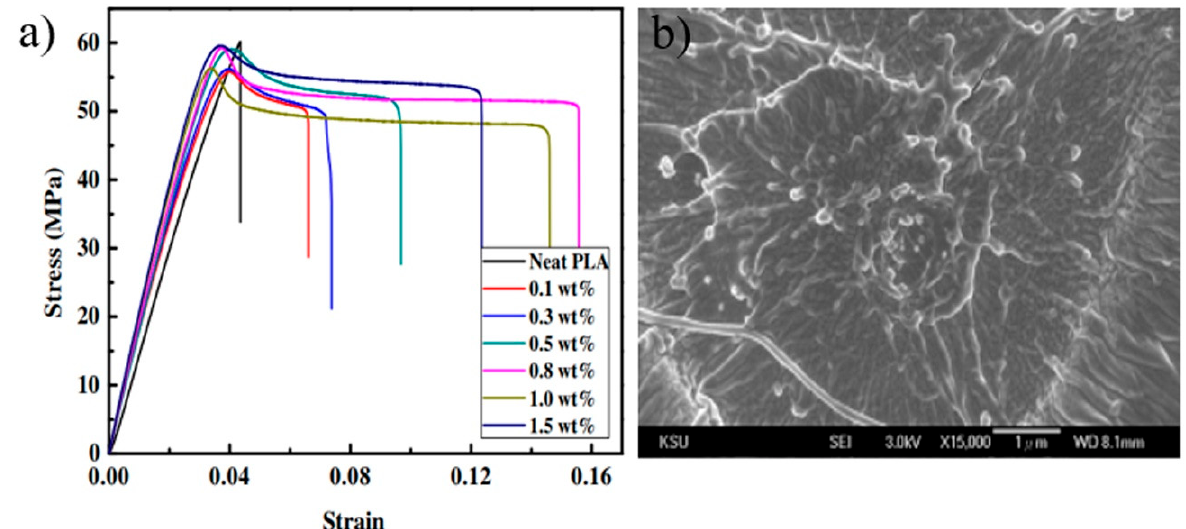
Figure 6. ( a ) The stress–strain curve of neat PLA and PLA composites. ( b ) The fracture morphology after the tensile test of PLA composite [38].